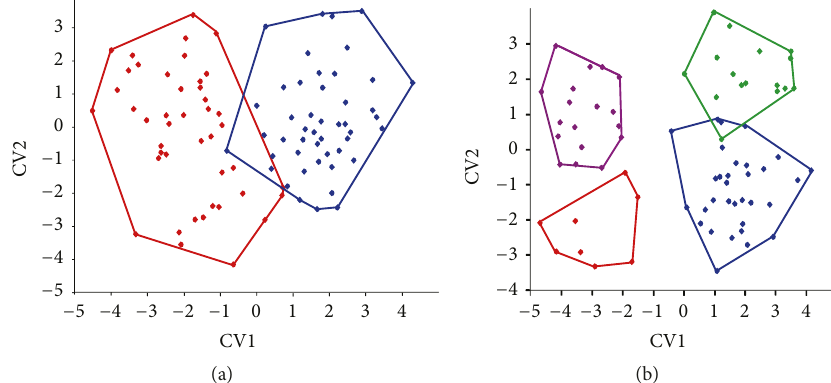
Figure 3: (a) Score position of MANOVA/CVA for each species, at the space of the first and second canonical axes. Red dots: Astyanax paranae , blue dots: Astyanax rivularis . (b) Score position of MANOVA/CVA for each lineage, at the space of the first and second canonical axes. Green dots: lineage A1, blue dots: lineage A2, purple dots: lineage B1, and red dots: lineage B2.